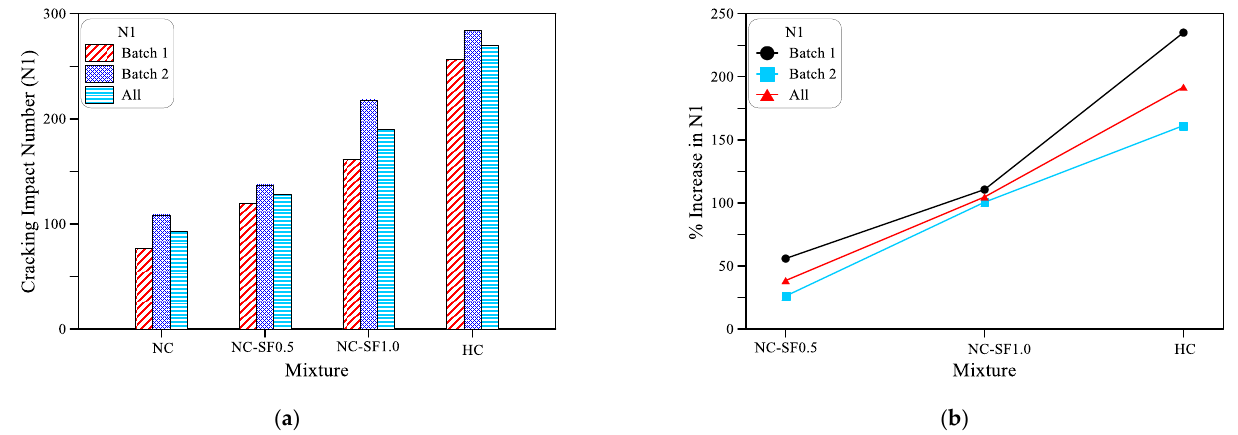
Figure 5. Impact results at cracking stage ( a ) N1 records of all mixtures ( b ) percentage increase in N1 of the fibrous and HC mixtures compared to the NC mixture.